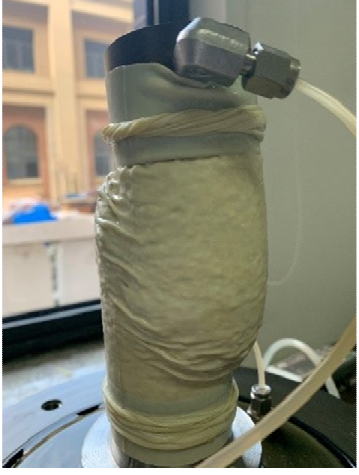
Figure 8. Calcareous sand samples after the test.